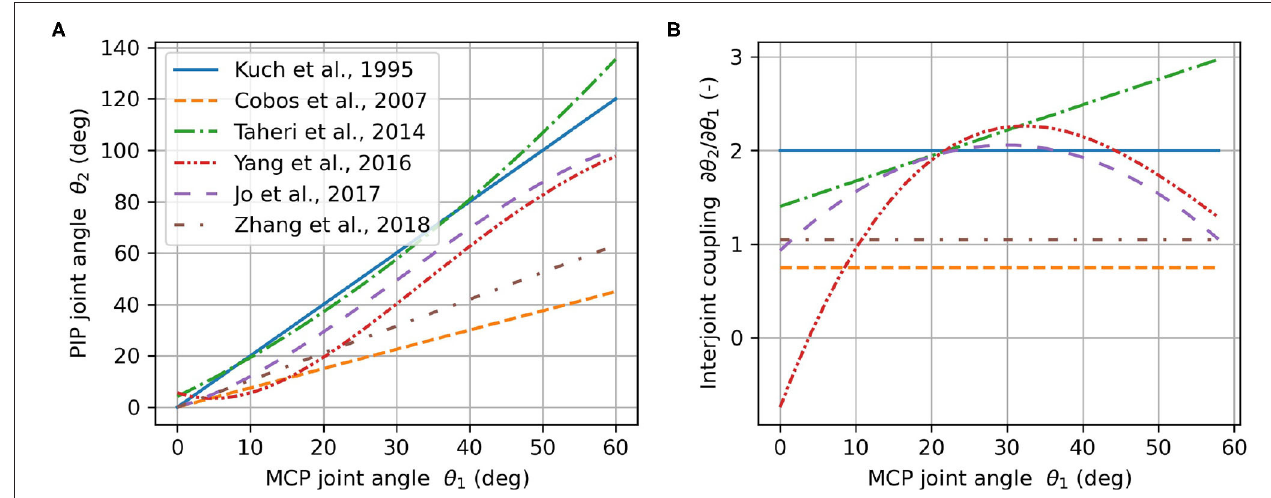
FIGURE 4 | Angular relationship between PIP and MCP joints (A) and the corresponding interjoint coupling (rate of change) (B) according to